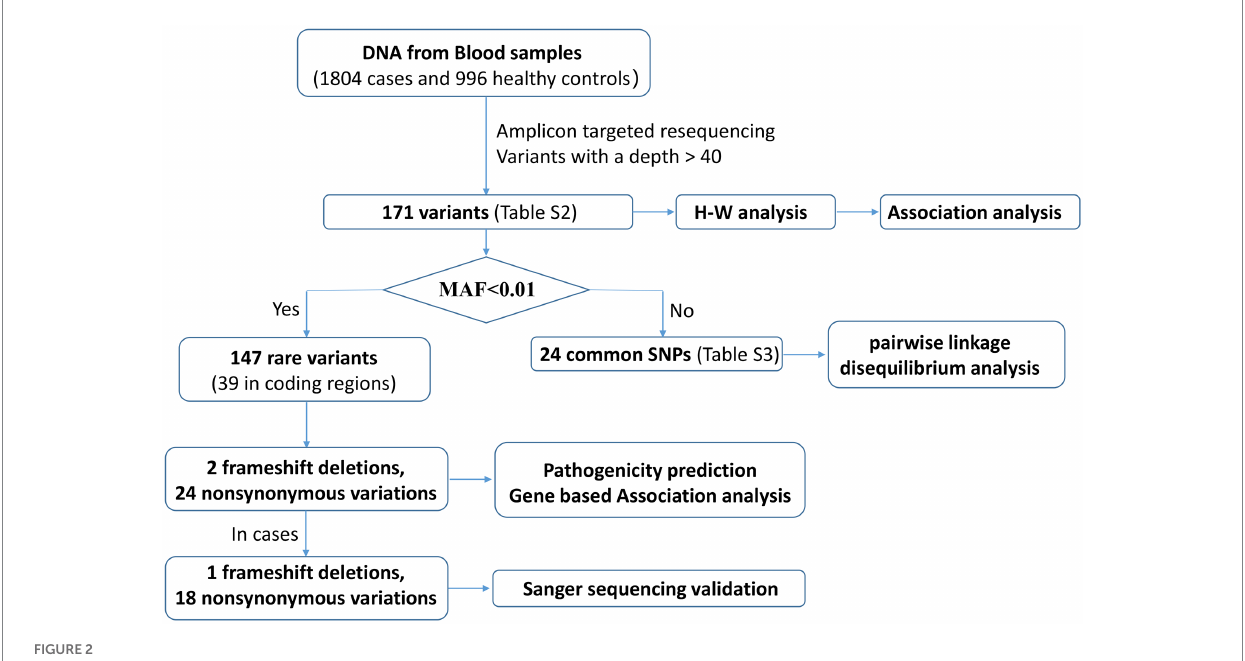
FIGURE 2 The pipeline of variants QC and